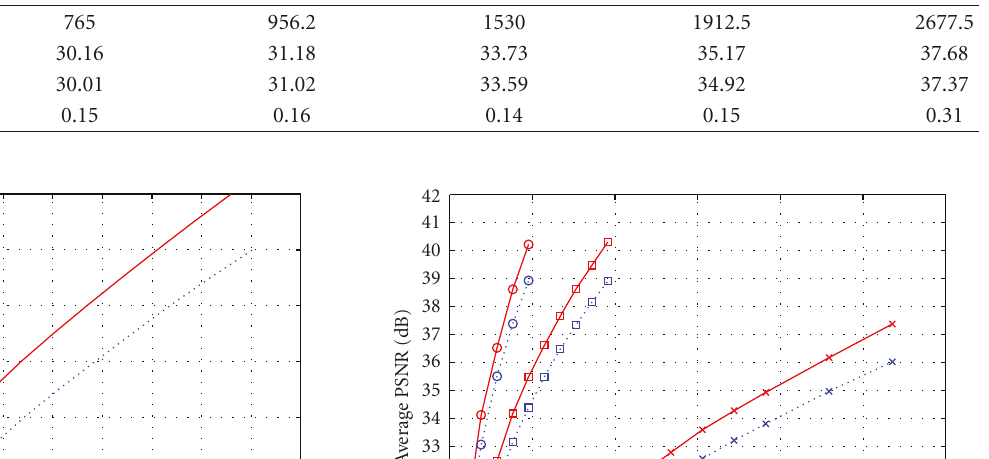
Table 2: Performance gap: high motion.